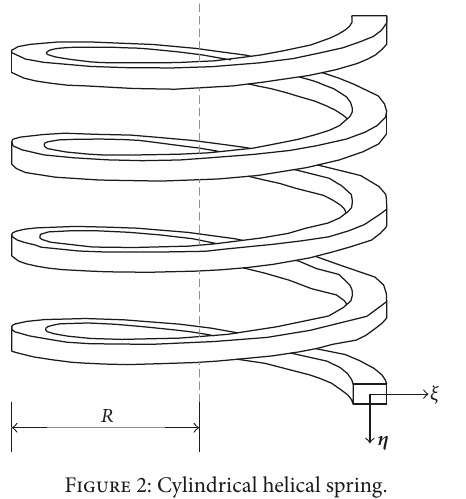
Figure 2: Cylindrical helical spring.